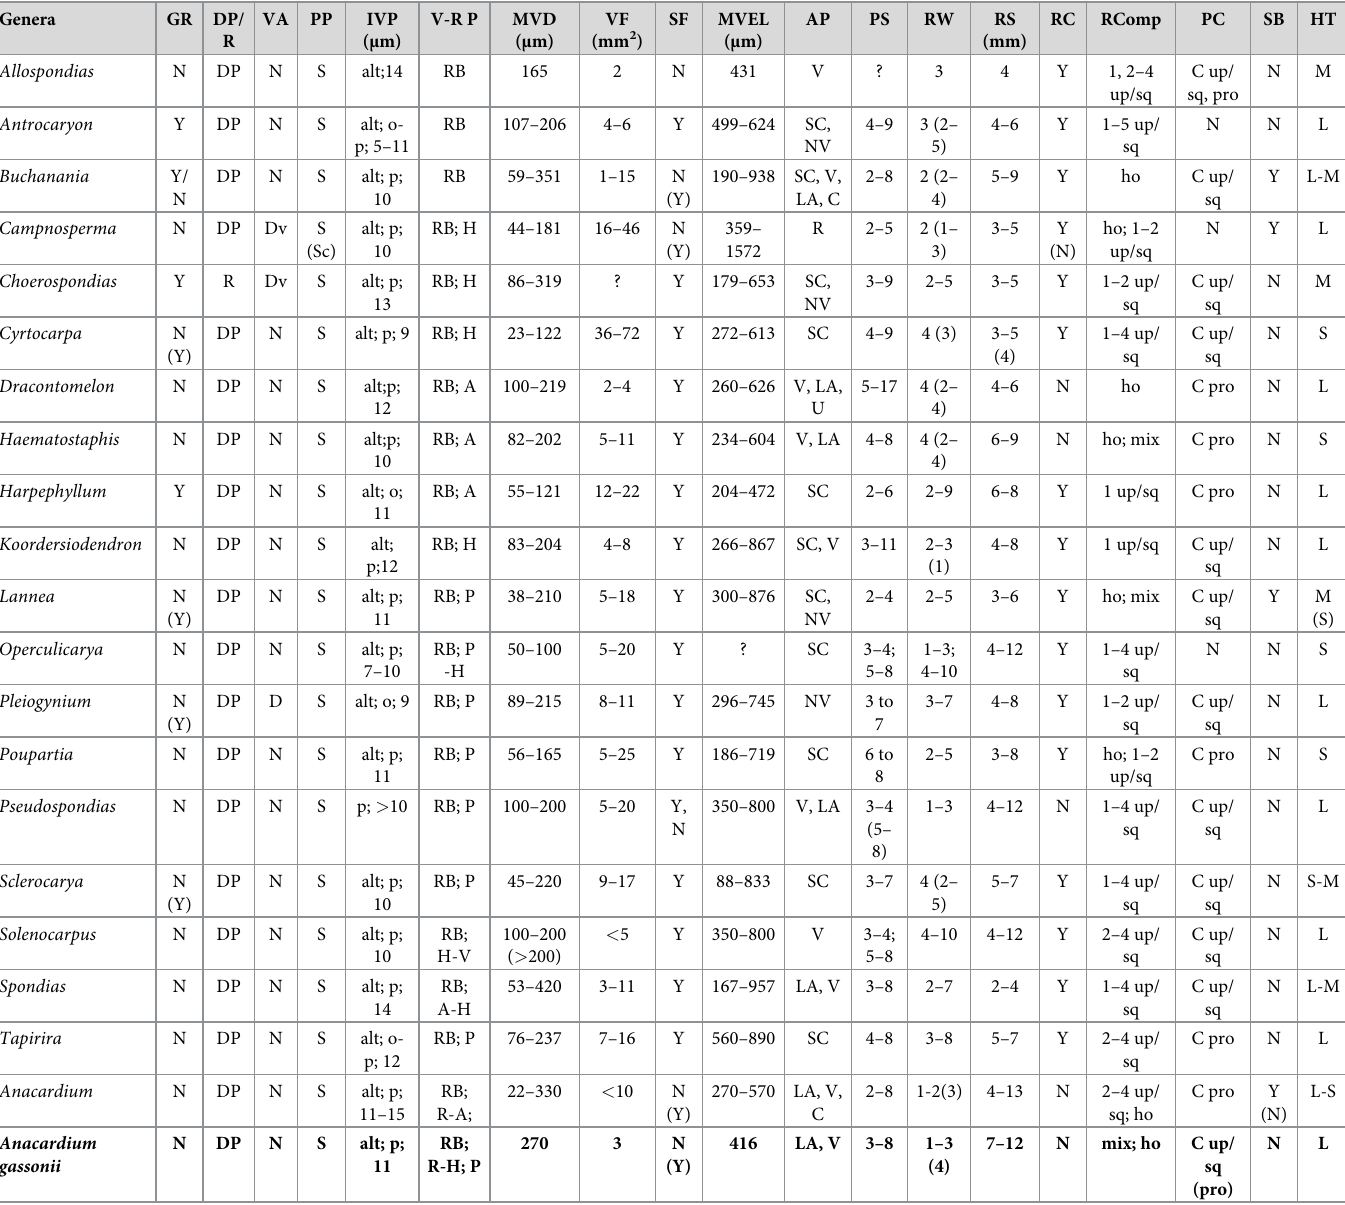
Table 1. Comparative table between Anacardium gassonii and selective traits of Spondioideae and two Anacardioideae genera.